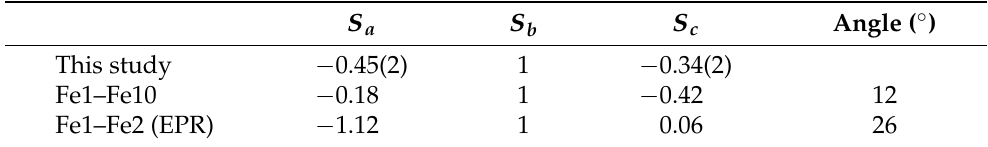
Table 3. For an easy axis vector specified in cell units ( S a S b S c ), the direction is fully determined by two parameters. The orientation obtained here is compared with the Fe1–Fe10 direction and also the Fe1–Fe2 direction suggested by the previous EPR study [13]. The fitted orientation is close to the plane formed by the Fe1, Fe2, and Fe10 sites and is close to the Fe1–Fe10 axis as shown by the angle given in the final